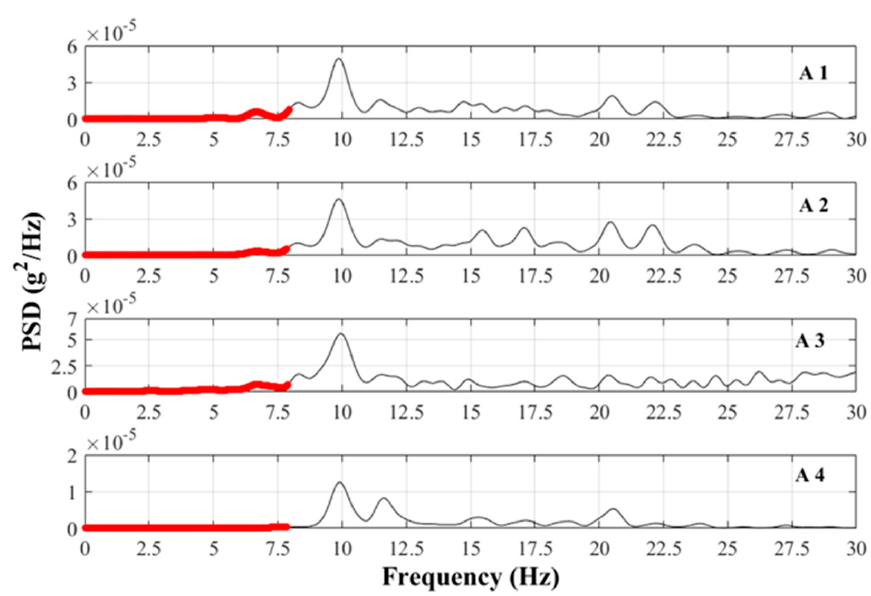
Figure 9. PSDs plots of footfall triggered responses. Human discomfort critical range in red.